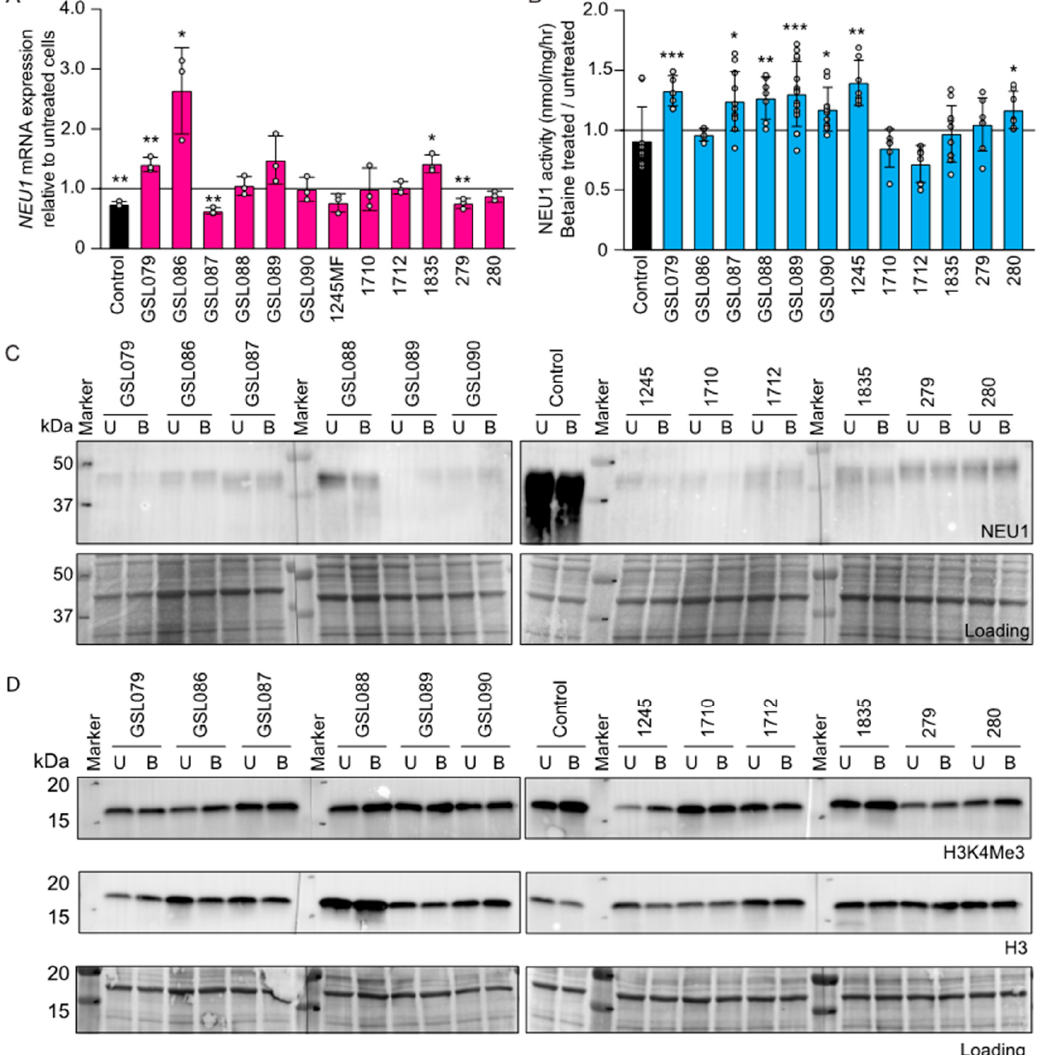
Figure 4. Betaine modulates NEU1 levels in sialidosis type I fibroblasts. ( A ) Levels of NEU1 mRNA in sialidosis fibroblasts treated with betaine. Values were calculated relative to those in control cells ( n = 3). ( B ) NEU1 activity assayed in sialidosis type I fibroblasts ( n ≥ 5) after treatment with betaine. ( C ) Representative immunoblot of betaine-untreated (U) and -treated ( B ) sialidosis fibroblasts probed with human anti-NEU1 antibody. Coomassie-stained immunoblot used as the loading control ( n = 3). ( D ) Representative immunoblot of betaine-treated sialidosis type I fibroblasts probed with anti-Histone H3 lysine 4 trimethylation (H3K4me3) and anti-histone H3 (H3) antibodies. Coomassie-stained immunoblot used as the loading control ( n = 3). Graphs are presented as mean ± SD. Statistical analysis was performed using Student t -test. * p < 0.05, ** p < 0.01, *** p < 0.001.